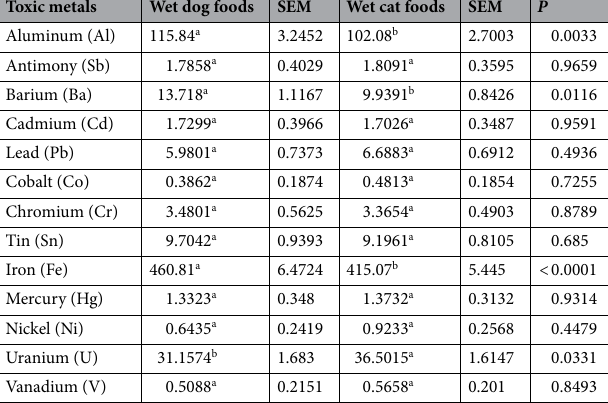
Table 7. Comparison of detected toxic metals concentrations (mg/kg) between wet foods for dogs and cats. SEM standard error mean, P probability of significance. a,b Means followed by different letters in the lines differed (P < 0.05).